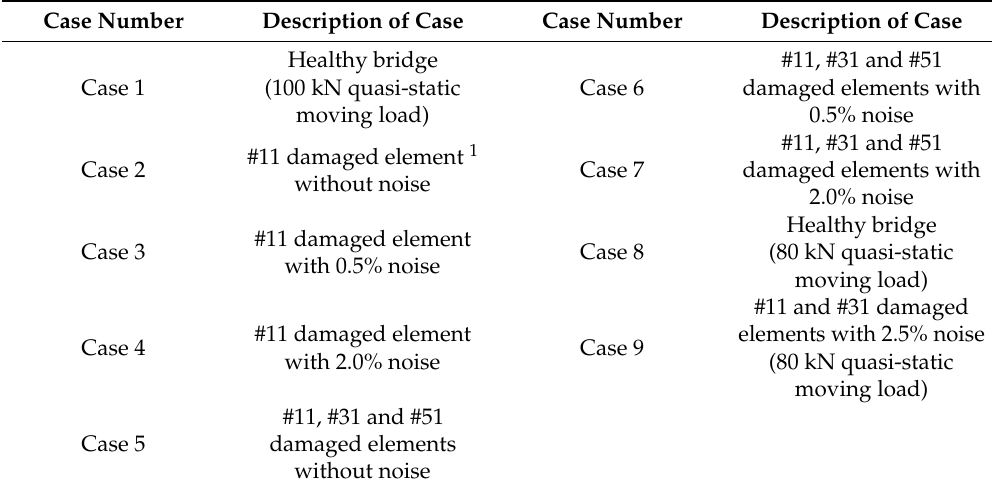
Table 1. Descriptions of all cases for the numerical example.